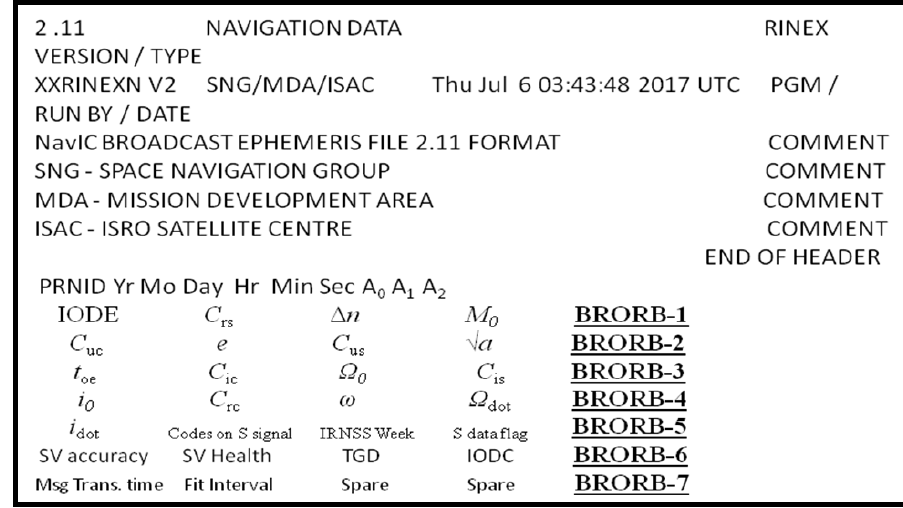
Fig. 1. Format for RINEX navigation data of